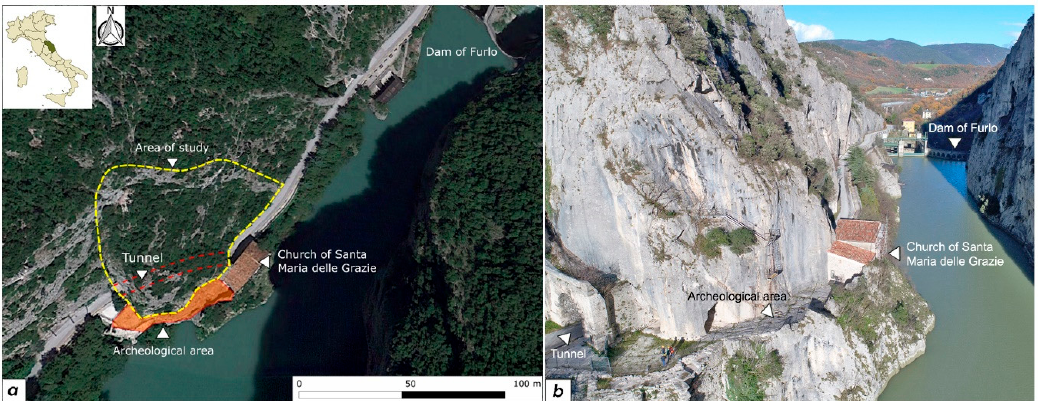
Figure 1. Location of the study area ( a ): aerial orthophoto of “Canavaccio” Section (Nr. 280090 from the Marche Regional Technical Cartography at a scale of 1:10,000) used as background image; inset map shows the location of the study area in Italy; perspective view of the Furlo Gorge from an Unmanned Aerial Vehicle (UAV) ( b ): in the background the dam, in the foreground the Roman Via Flaminia road (to the left), and the Church of “Santa Maria delle Grazie” (in the center).